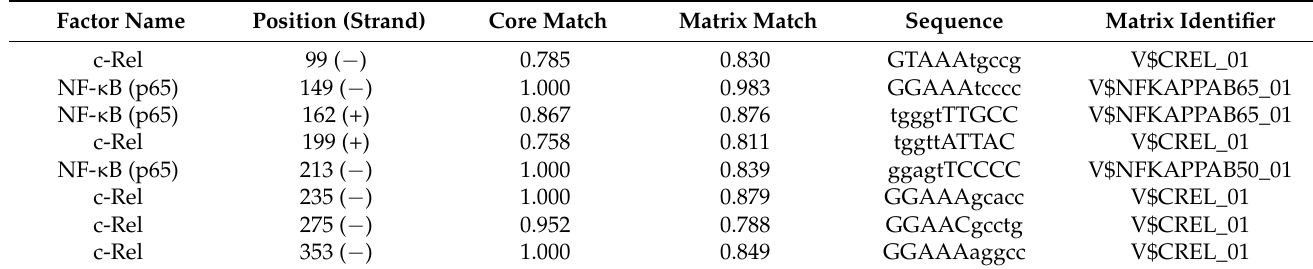
Table 1. Analysis of NF- κ B bound sites of BIRC3 promoter in UCSC database.